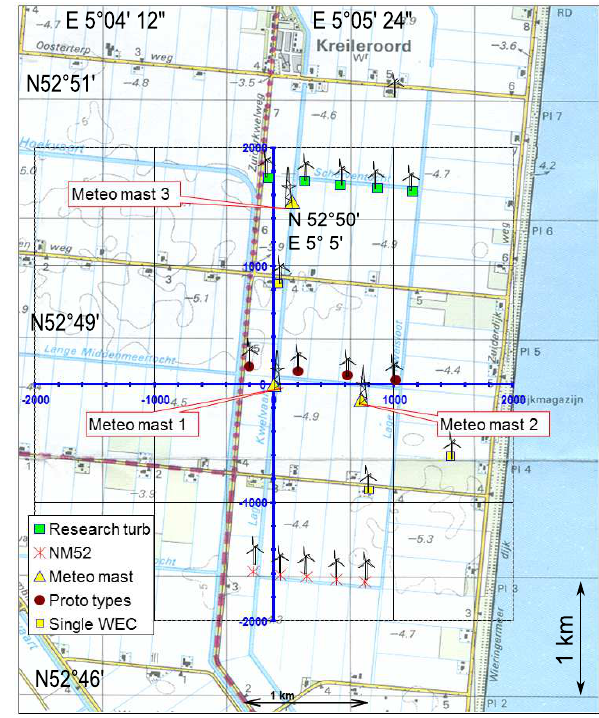
Figure 1. EWTW test site with Nordex N80 prototype wind tur- bine.